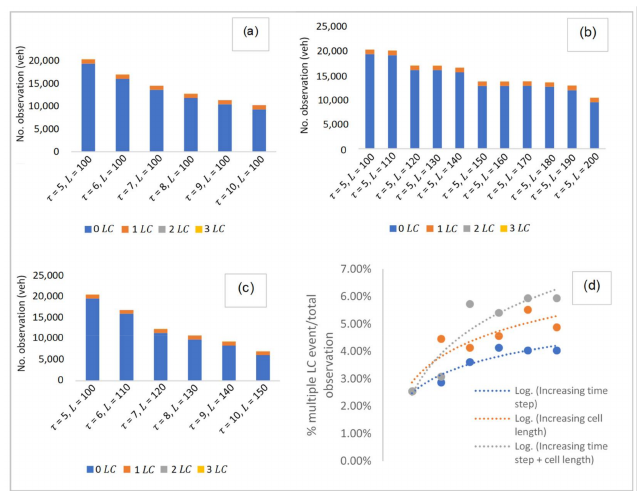
Figure 5. The number of observations processed based on ( a ) increasing time step, ( b ) increasing cell length, ( c ) increasing time step and cell length; ( d ) comparing the number of observations for multiple LC